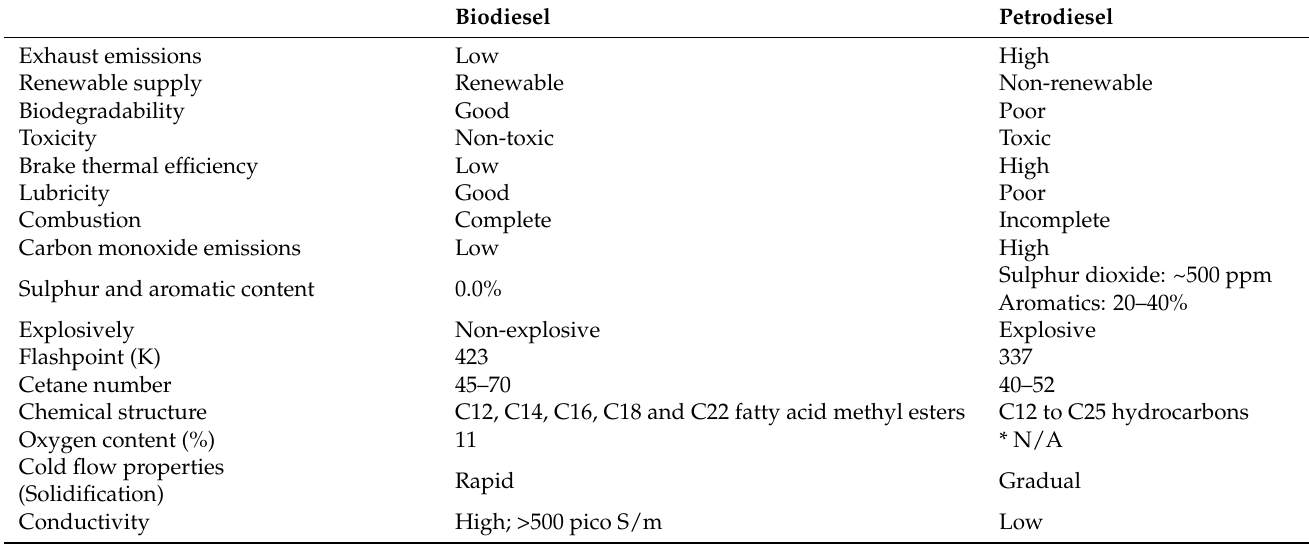
Table 1. Pure biodiesel properties versus petrodiesel [23–27]. Biodiesel